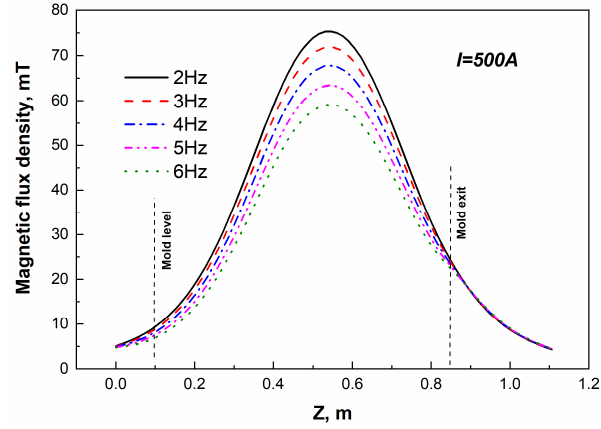
Figure 9. Distribution of centerline magnetic flux density along the axial direction under different current frequencies.